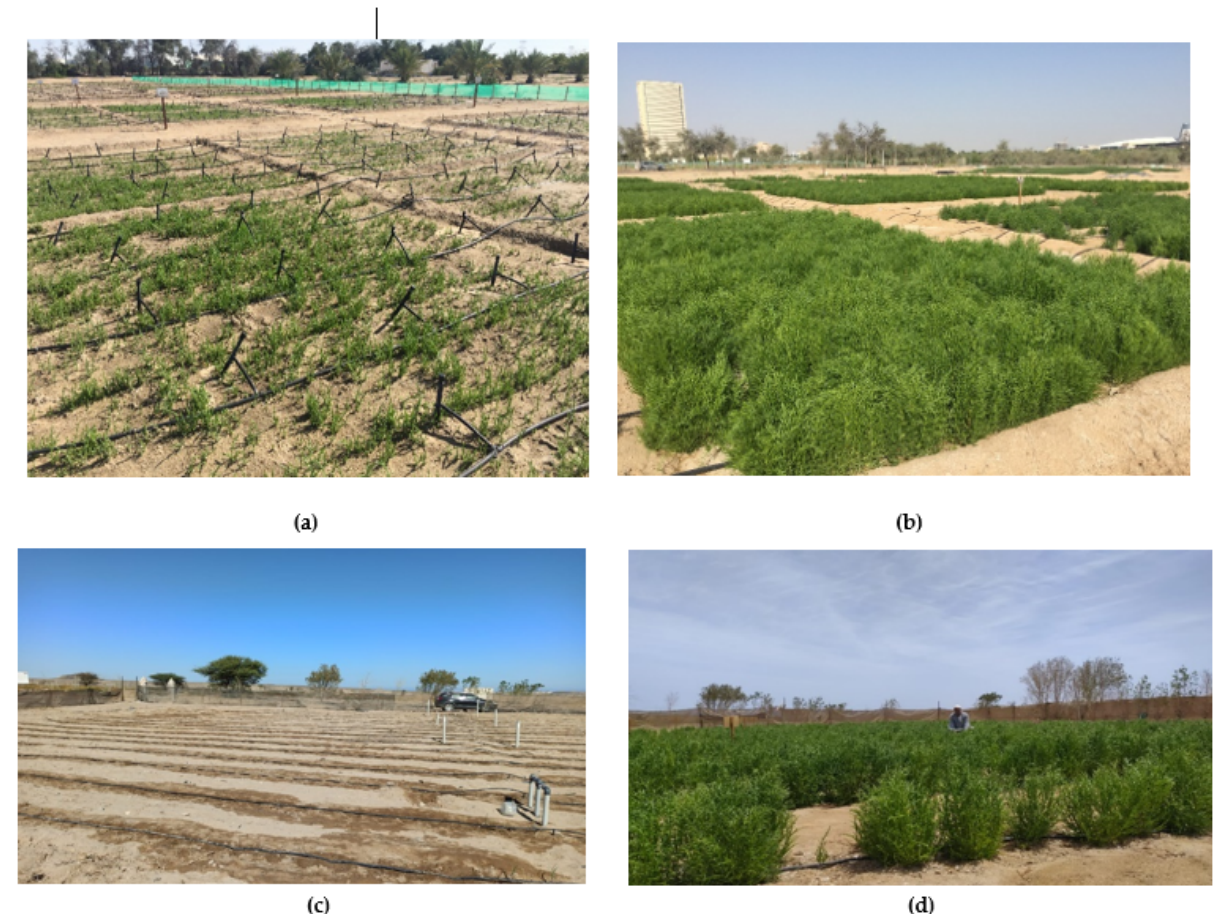
Figure 1. Salicornia bigelovii field experiments at ICBA’s experimental station at ( a ) young and ( b ) advanced vegetative stage and at Mubarak Valley in Marsa Alam at ( c ) sowing and ( d ) advanced vegetative stage. Table 1. Details of the S. bigelovii experiments implemented at ICBA in Dubai in the United Arab Emirates and Mubarak Valley in Marsa Alam in